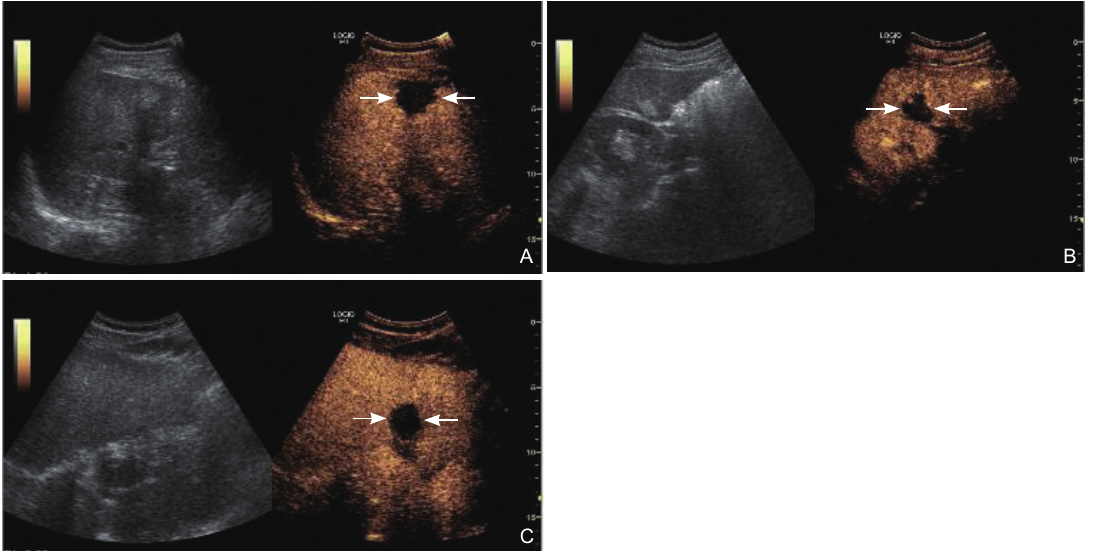
Figure 3 Post-ablation contrast-enhanced ultrasonography images. (A, B, and C) No enhancement was observed in colorectal liver metastatic lesions.